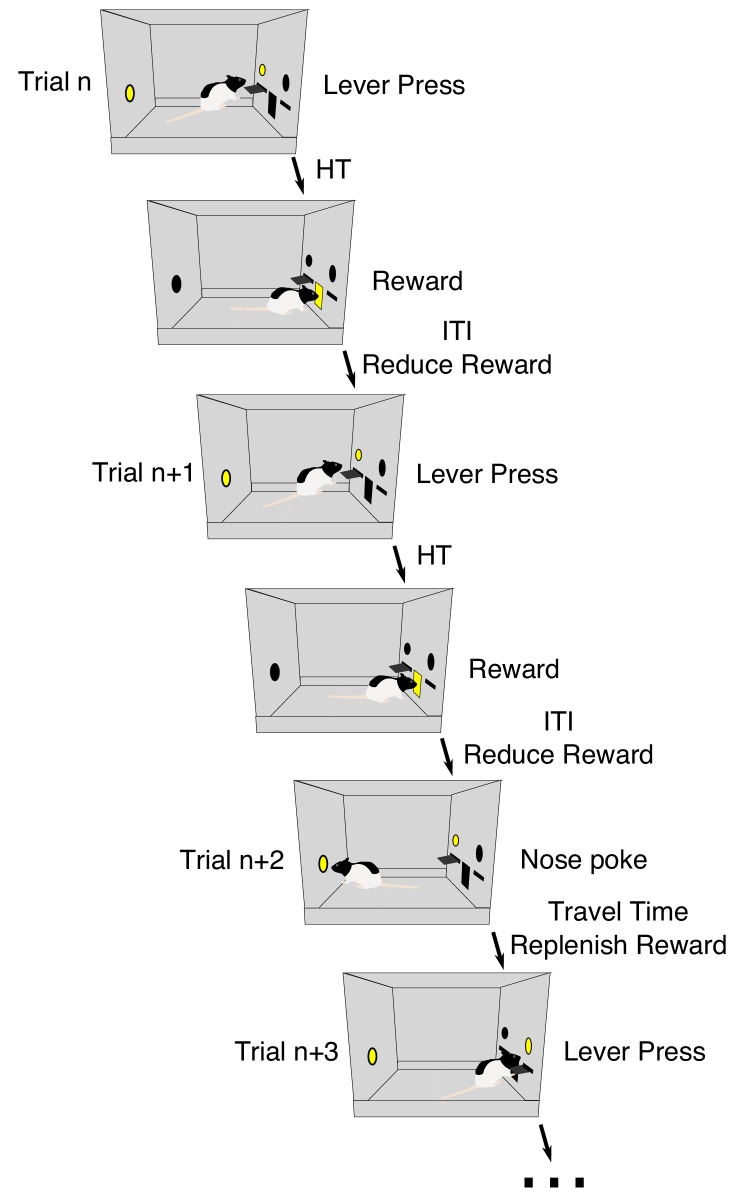
Diagram of the foraging task.Rats press a lever to harvest reward from the patch then receive reward in an adjacent port following a pre-reward delay (handling time or HT). After receiving reward, there is a post-reward delay (inter-trial interval or) before rats can make their next decision. Rats can leave the patch by nose poking in the back of the chamber (trial n+2), which initiates a delay simulating time to travel to the next patch, after which, rats can harvest from a new replenished patch.